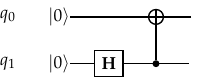
Figure 29. The local circuit for the second update frame of the one-dimensional PQCA